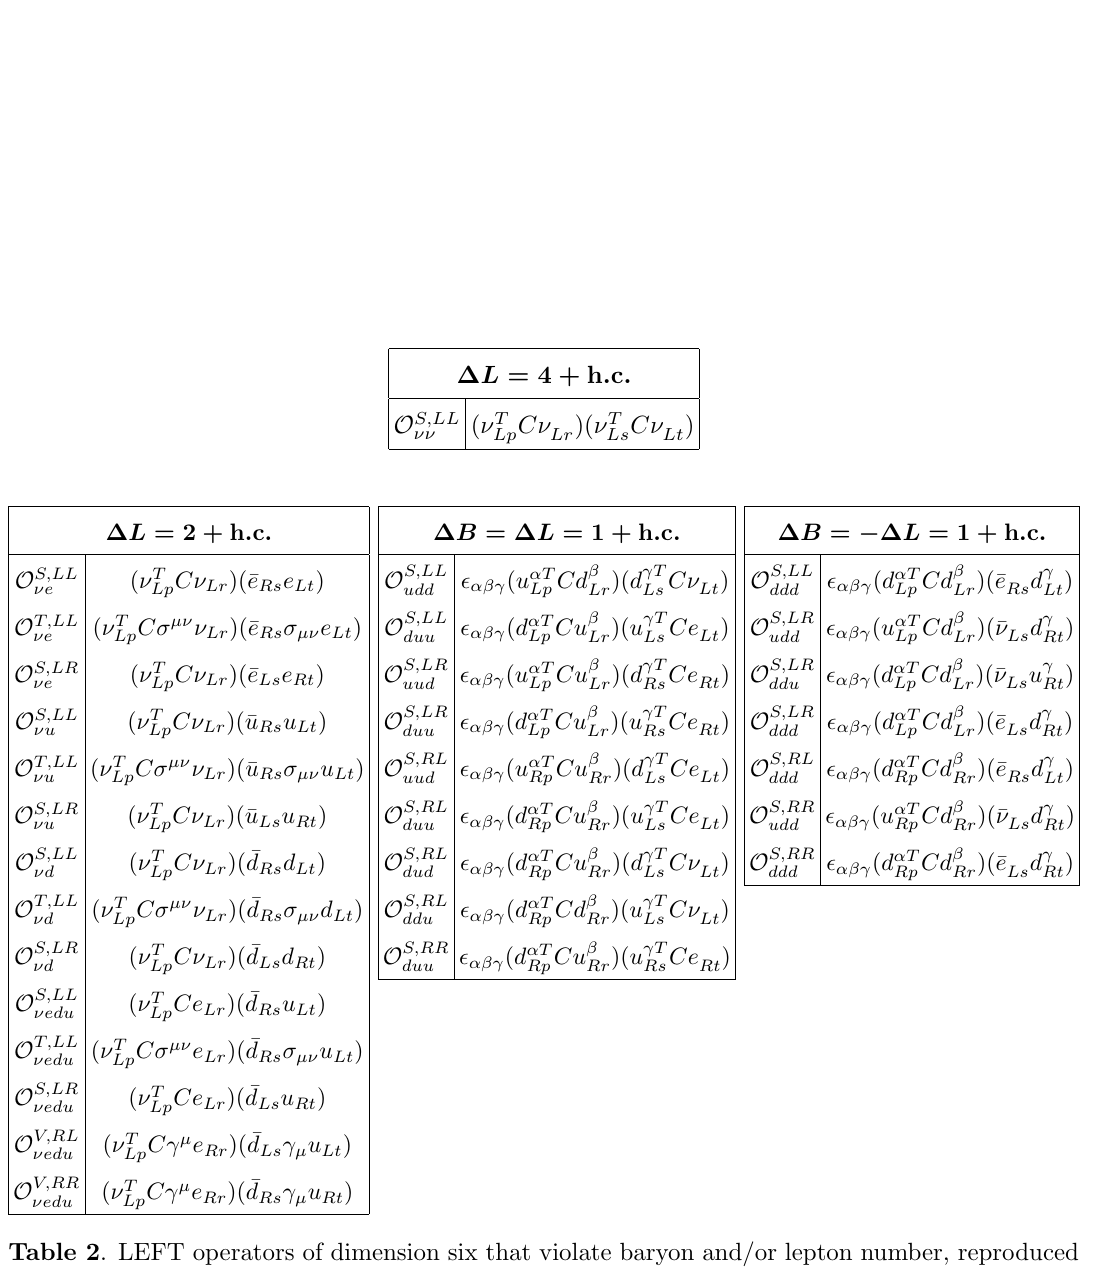
Table 2 . LEFT operators of dimension six that violate baryon and/or lepton number, reproduced from ref.